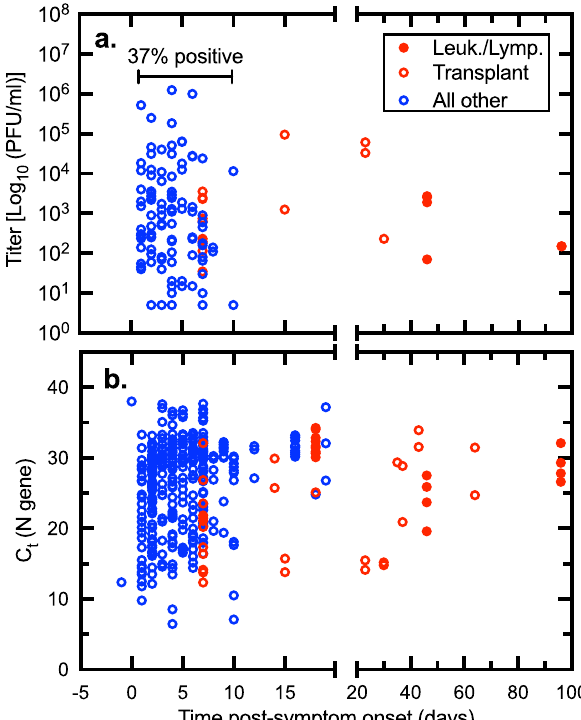
Figure 3. Impact of sample timing on SARS-CoV-2 virus detection. The time post-onset was calculated from interviews and/or chart review. ( a ) Virus titer where it could be detected. ( b ) All the C t measurements acquired over the study. In most cases, the capacity to detect virus drops off precipitously about a week after case onset (blue data points). However, both RNA (lower panel) and PFU (upper panel) are detected for many days or weeks later where the patient is immunocompromised (red data points). Figure prepared using Prism v9.3 (https:// www. graph pad.